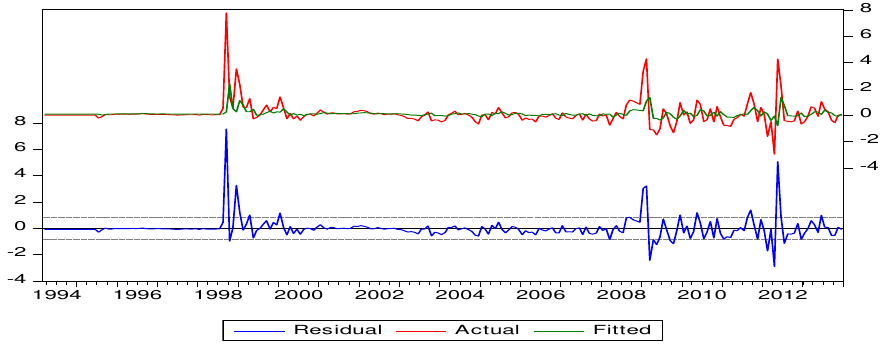
Fig. 1. Results of the residuals/ARCH effect test